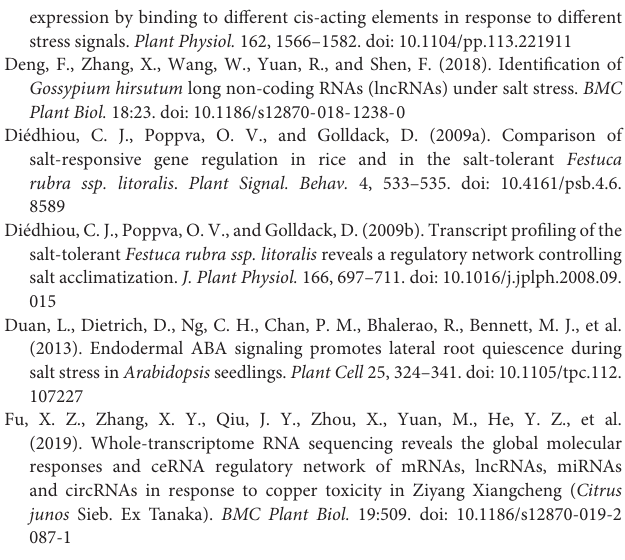
Supplementary Table 1 | The primers used in qRT-PCR validation. Supplementary Table 2 | The list of DEmRNAs. Supplementary Table 3 | GO enrichment of DEmRNAs. Supplementary Table 4 | The list of lncRNAs. Supplementary Table 5 | The list of DElncRNAs. Supplementary Table 6 | The list of antisense pairs between DElncRNAs and DEmRNAs. Supplementary Table 7 | The list of cis -acting between DElncRNAs and DEmRNAs. Supplementary Table 8 | The list of circRNAs. Supplementary Table 9 | The list of DEcircRNAs. Supplementary Table 10 | The list of DEmiRNAs. Supplementary Table 11 | The list of DEmiRNA-mRNA interactions. Supplementary Table 12 | The list of DEmiRNA-DEmRNA interactions. Supplementary Table 13 | The list of DEmiRNA-DEcircRNA interactions. Supplementary Table 14 | The list of DEmiRNA-lncRNA